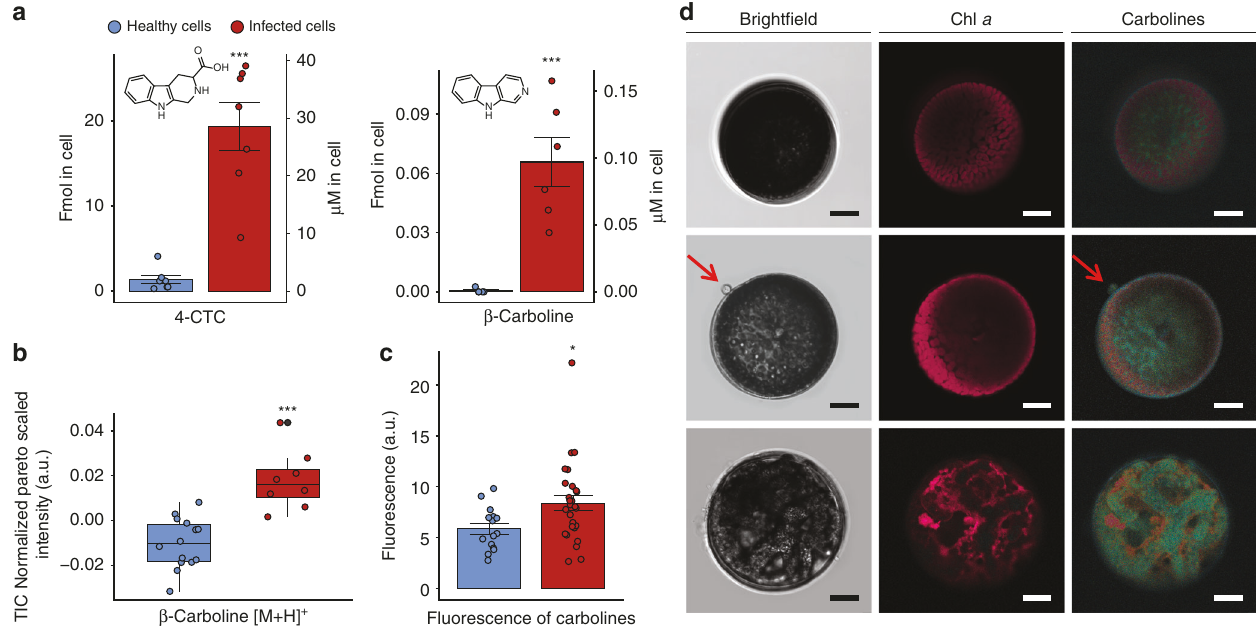
Fig. 2 Quanti fi cation of carbolines in healthy and oomycete-infected diatom cells. a The carbolines quanti fi ed with UHPLC-HR-MS/MS are elevated in extracts from infected cells (left Y -axes). The intracellular concentrations in µ M are calculated based on the cell volume (right Y -axes). The Student ’ s test for both carboline concentrations found statistical signi fi cance between healthy and infected extract (Mann – Whitney rank sum test for 4-CTC, n = 7, T = 77 000; Student ’ s t -test for β -carboline t = 4.9, df = 9, *** for p value <0.001 for both tests). b Pareto scaled TIC normalized intensity of the β - carboline ion trace m / z 169.0761 was signi fi cantly higher in the AP-MALDI-HR-MS pro fi les of infected algal cells (Student ’ s t -test, healthy cells n = 14, infected cells n = 8, t = − 5.3 df = 20, *** for p value <0.001). c Means of cellular carboline fl uorescence intensities (Mann – Whitney rank-sum test, n = 15 for healthy cells, n = 27 for infected cells, T = 233 000, * for p value <0.05). All error bars indicate the standard error of mean. The box-plots are displayed with the maximum, minimum, median lines, and fi rst/third quartiles and the samples as points. The outliers are displayed with a black dot. d The spatial localization and accumulation of the carbolines was observed with cLSM in healthy (upper row), early infected (middle), and late infected (lower row) cells. The microscopy pictures were taken in bright fi eld (left) and the auto fl uorescence emission of chlorophyll a (Chl a ) (middle) and carbolines (right) were recorded with an excitation wavelength of 405 nm. Scale bars equal 10 µ